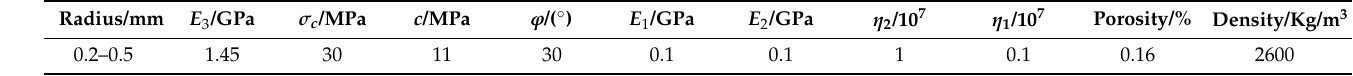
Table 7. The value of parameters in the DEM